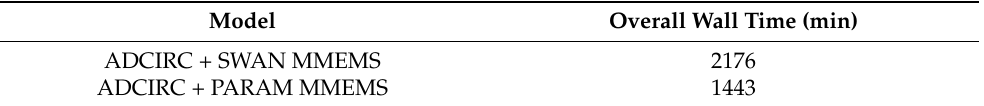
Table 2. Combined wall clock time of all hindcast, S1, and S2 simulations in one MMEMS forecast